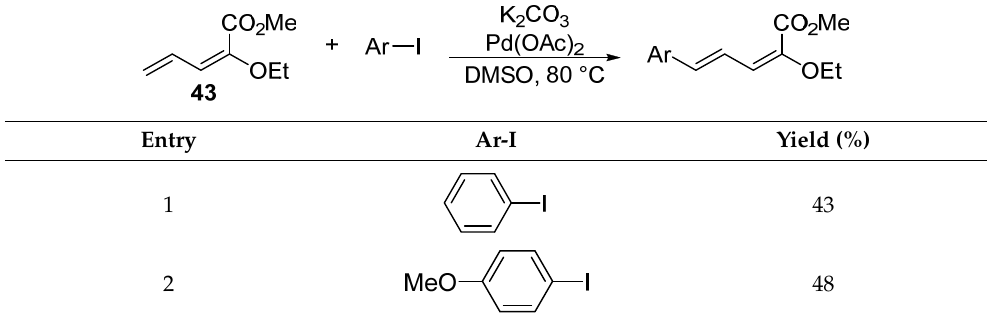
Table 9. Heck coupling according to Venturello’s group.